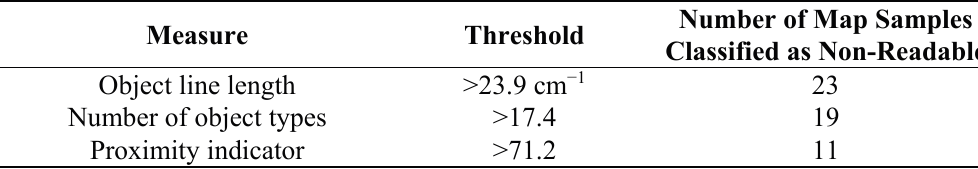
Table 7. Threshold values for classifying a map sample as